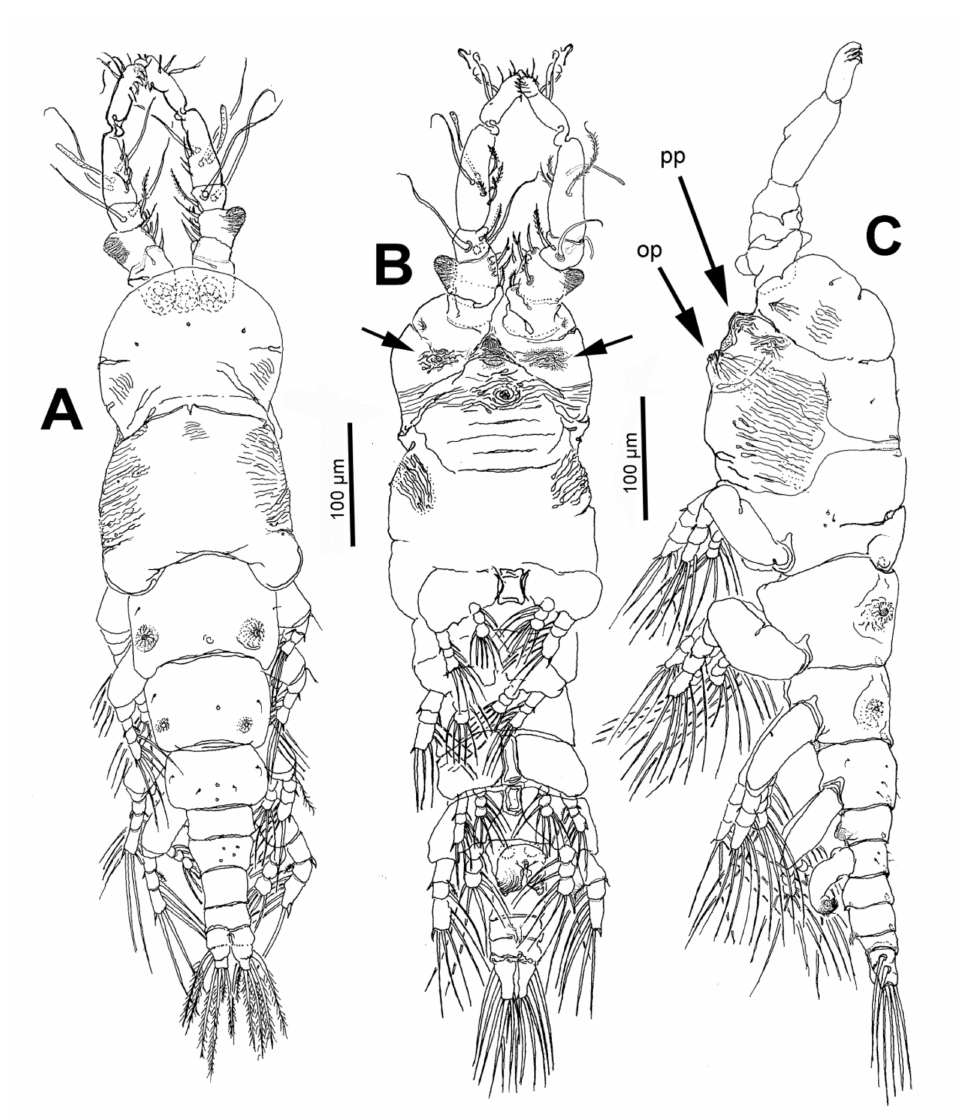
Figure 2. Caromiobenella brasiliensis (Dias and Su á rez-Morales, 2000) comb. nov., from Rio de Janeiro area, adult male (MNRJ30136). ( A ) Habitus, dorsal view; ( B ) Habitus, lateral view; ( C ) Same, ventral view. Arrows indicate antero-ventral nipple-like cuticular processes. Legend: pp = preoral process, op = oral